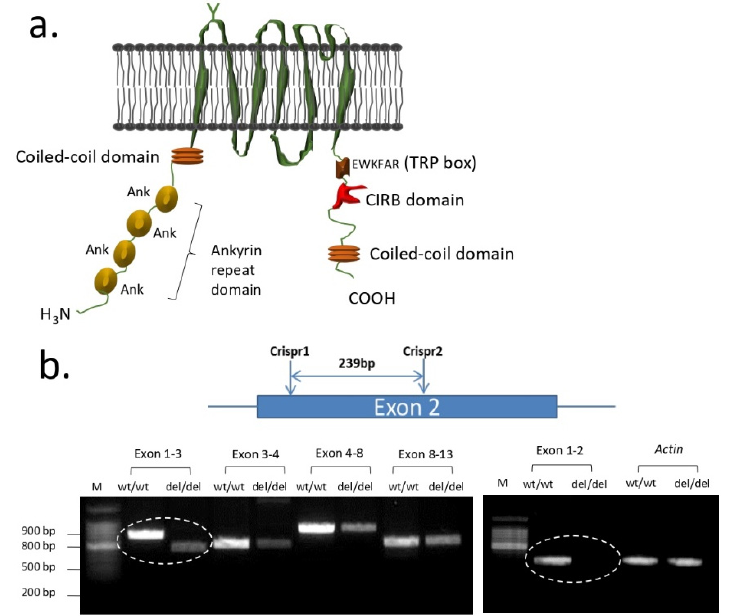
Figure 2. TRPC6 channel subunits and Crispr/Cas9 editing to create Trpc6 del/del /rats. ( a ) Organization of TRPC6 subunits including ankyrin repeats on the amino-terminal cytosolic domain, the six transmembrane alpha-helices, and regulatory domains on the carboxyl-terminal cytosolic domain. ( b ) Crispr/Cas9 editing of the Trpc6 gene was used to delete a 239 bp region located in exon 2, which normally encodes ankyrin repeats 1 and 2. As a result of the deletion, the animals splice out all of Exon 2 in a post-translational process. RT-PCR analysis using primers designed to span the exons indicated shows that exon 2 is missing from the Trpc6 transcripts isolated from kidneys of Trpc6 del/del rats but is present in their Trpc6 wt/wt littermates. More details are found in [50]. The proteins encoded by Trpc6 del do not form functional channels